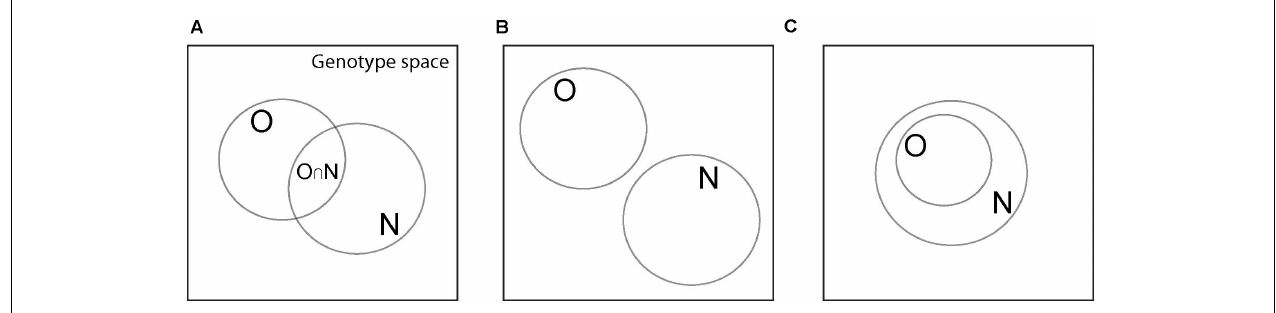
FIGURE 1 | Various possible relationships among sets of genotypes with the same phenotype. Large squares symbolize genotype space, circles correspond to sets of genotypes with the same phenotype, which can be either an old phenotype P O (set O ), or a new phenotype P N (set N ). (A) The two genotype sets have a non-empty intersection (denoted by O ∩ N ), which is the main scenario I consider. (B) The two genotype sets have an empty intersection ( p ON = 0), which makes exaptation unlikely or impossible. (C) The set of genotypes with the old phenotype P O is a subset of that with the new phenotype P N . In this case, the new phenotype is an inevitable, possibly latent by-product of the old